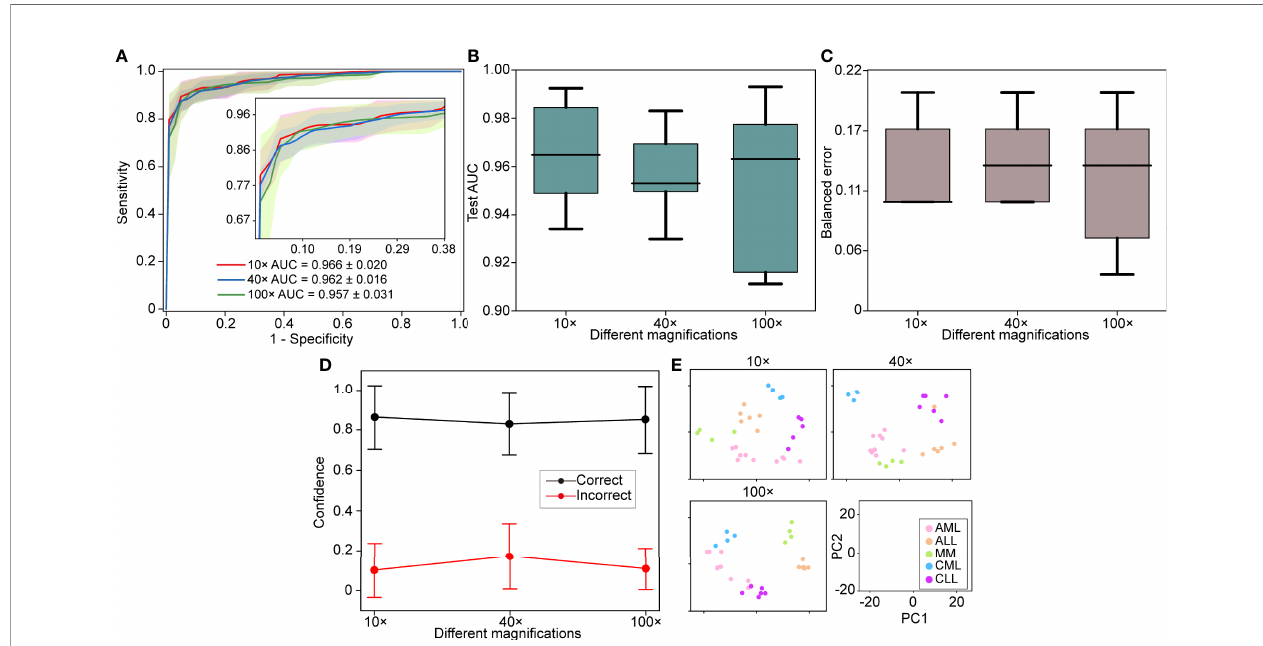
FIGURE 3 | Independent test set performance. (A) 5-fold mean test macro-averaged AUC ± s.d. of our model using 10×, 40×, and 100× objectives on the independent test set. The con fi dence band shows ±1 s.d. for the ROC. (B) Cross-validation test AUCs. (C) Cross-validation test balanced error. (D) Average con fi dence ( ± 1 s.d.) of correctly and incorrectly classi fi ed WSIs of the model. (E) Slide-level feature space for a single cross-validated fold using PCA in the validation and test